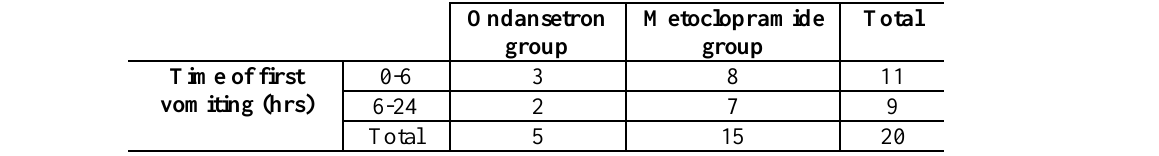
Table I : The incidence of vomiting in two study-groups in early (1-6 hrs.) and late post operative period (6 – 24 hrs.).